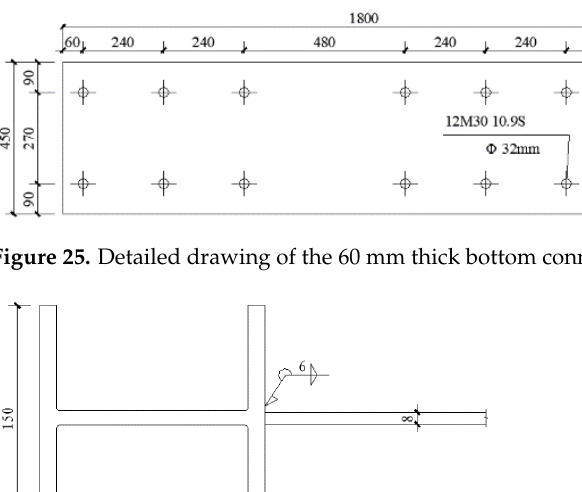
Figure 24. Detailed drawing of the 60 mm thick upper plate of specimen 2 (units: mm).